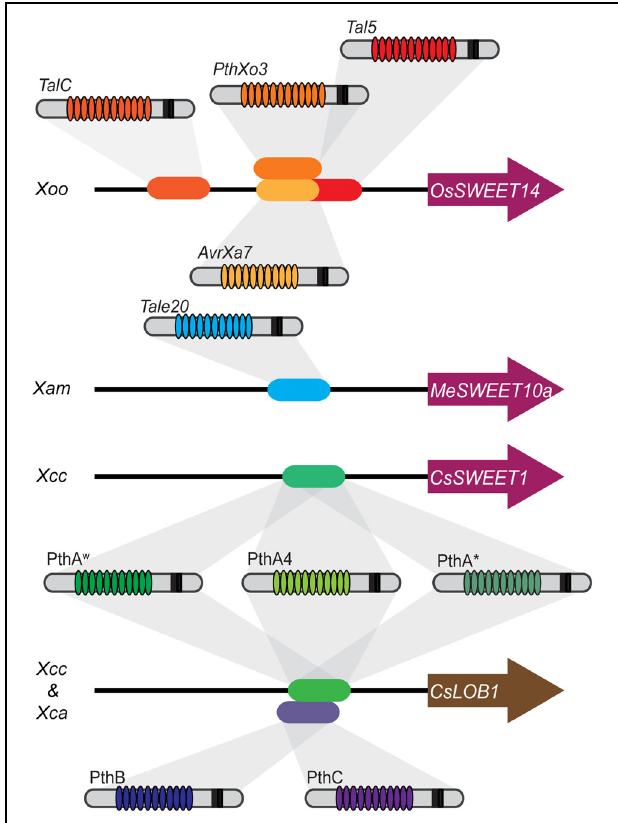
FIGURE 1 | Functional convergence in bacterial Transcription Activator-Like (TAL) effectors and plant targets. Several susceptibility targets of Xanthomonas oryzae pv. oryzae belong to Clade III of the SWEET family. Four TAL effectors from diverse Xoo strains belonging to different lineages and from distinct geographical origins target OsSWEET14 . TalC and Tal5 from the two Xoo African strains BAI3 (Burkina Faso) and MAI1 (Mali) bind to two distinct effector binding elements (EBEs). In addition, the OsSWEET14 promoter is targeted by two Xoo Philippine strains, PXO86 and PXO61 through the TAL effectors AvrXa7 and PthXo3. The corresponding EBEs partially overlap with the Tal5 EBE. The repeat variable di-residue (RVD) arrays and the number of repeats (not represented in the figure) for these three TAL effectors are significantly different, highlighting evolutionary convergence. Not shown in the figure is the case of the resistance gene Xa7 that recognizes AvrXa7 but not PthXo3 that is slightly divergent from AvrXa7. A similar case of convergence is observed for the induction of CsLOB1 which is targeted by PthB and PthC from X. citri ssp. aurantifolii and the PthA series from X. citri ssp. citri . PthA4, PthA w , and PthA ∗ (but not PthB and PthC) induce CsSWEET1 belonging to the Clade I of the SWEET family. However, a role in disease development has not been shown. A third species, X. axonopodis pv. manihotis , targets through TAL20 a member of the SWEET